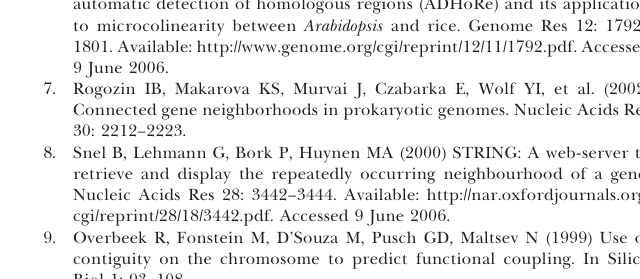
Figure S1. An Example of a Final Conflict in the Comparison of S. flexneri 2457t and S. typhi ty2 The cyan and the gray entries correspond to the same segment in S. typhi ty2. However, their corresponding segments in S. flexneri 2457t are different. Since these two entries are not collinear to any other